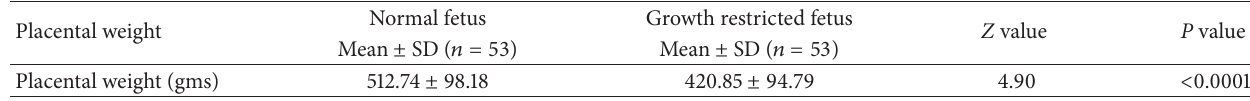
Table 5: The comparison of placental weight in study groups.